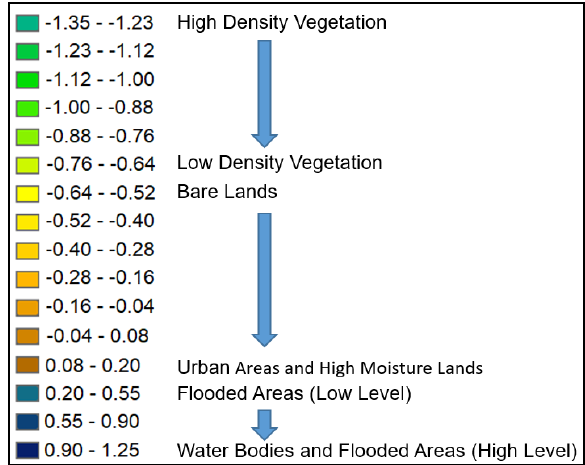
Figure 7. The classification legend for flood mapping with MNDWI McFeeters data.